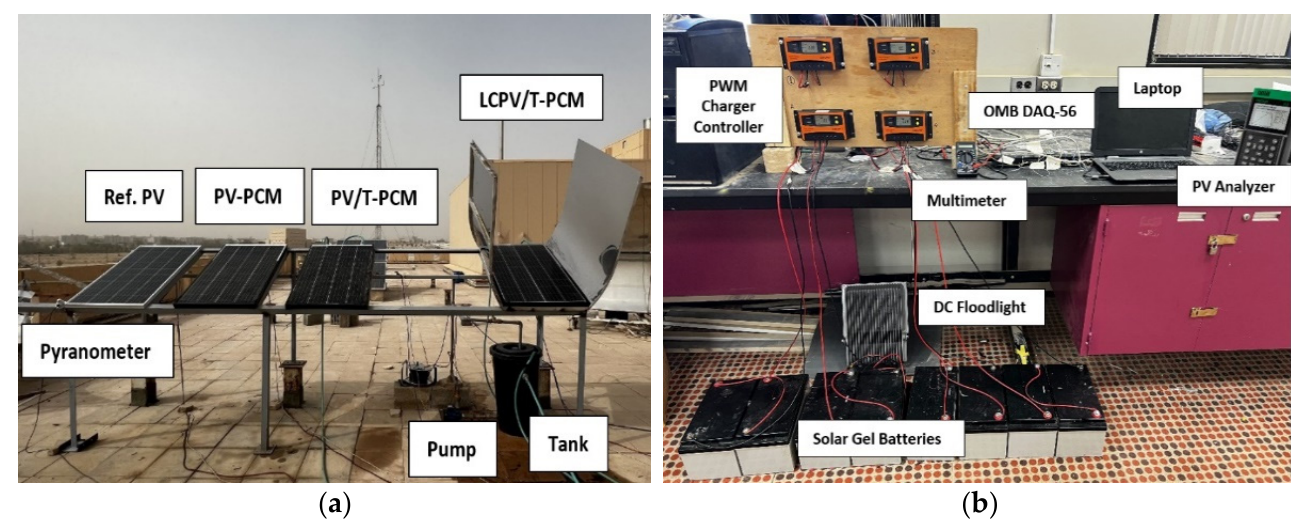
Figure 2. Pictorial views of the experimental layout: ( a ) outdoor facilities, and ( b ) indoor load, control, and measuring devices.